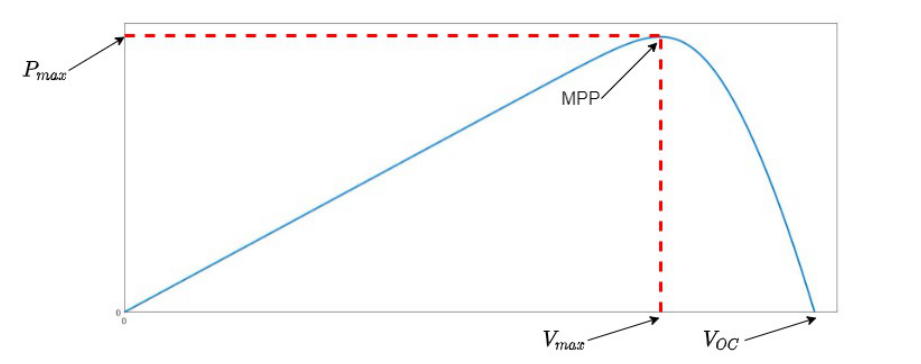
Figure 6. Example of a P(V) solar cell characteristic (blue) and the graphical definition of the maximum power point